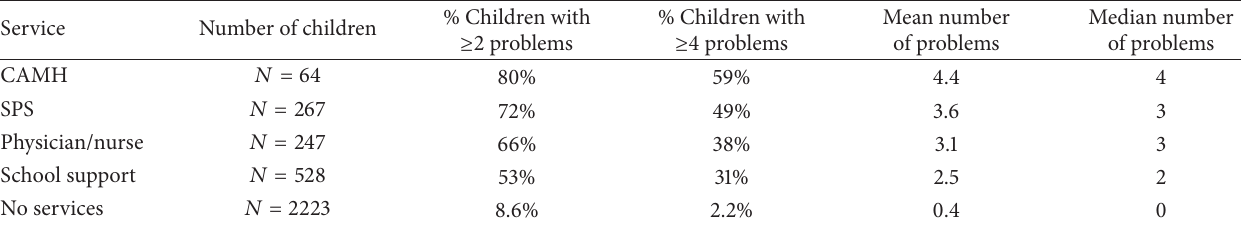
Table3:Unidentifiedchildren,percentofreferredchildrenscoringabove95thpercentile ≥ 2and ≥ 4problemareas,meanandmediannumber